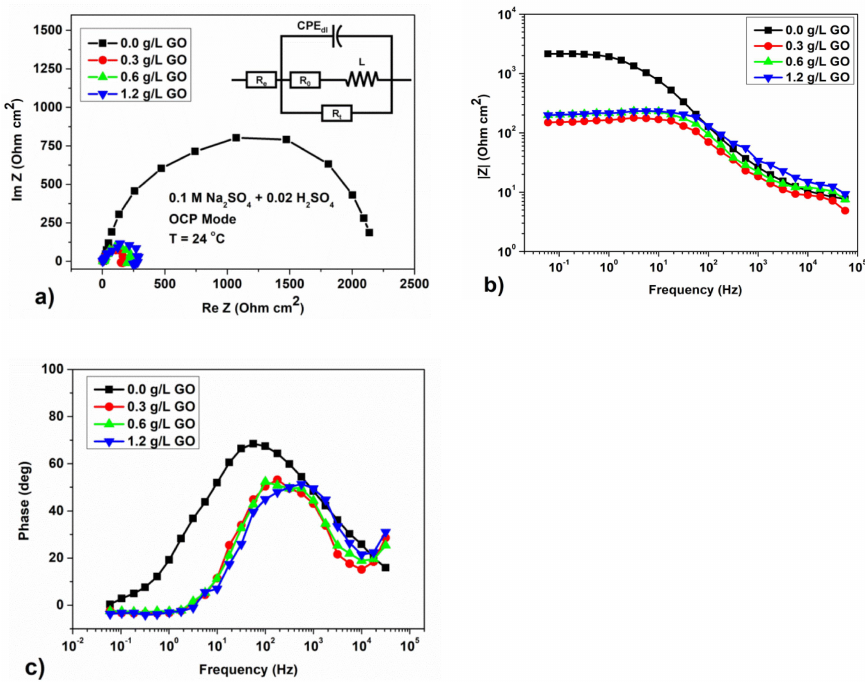
Figure 7. Results of measurements of electrochemical impedance for samples with different concentra- tions of GO in a solution of 0.1 M Na 2 SO 4 + 0.02 M H 2 SO 4 at OCP; ( a ) Nyquist curves and equivalent scheme for corrosion of steel with a protective coating in a solution of 0.1 M Na 2 SO 4 + 0.02 M H 2 SO 4 ; ( b ) Bode diagrams; and ( c ) frequency dependence of the phase angle of the electrochemical